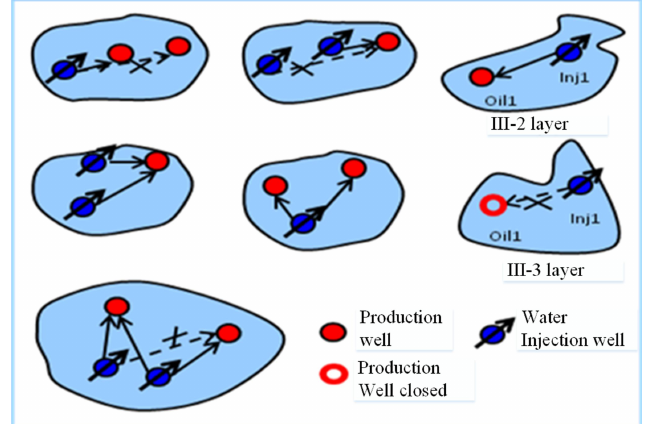
Figure 2—Injection-production relations influenced by well pattern, such as indirect connections and pressure